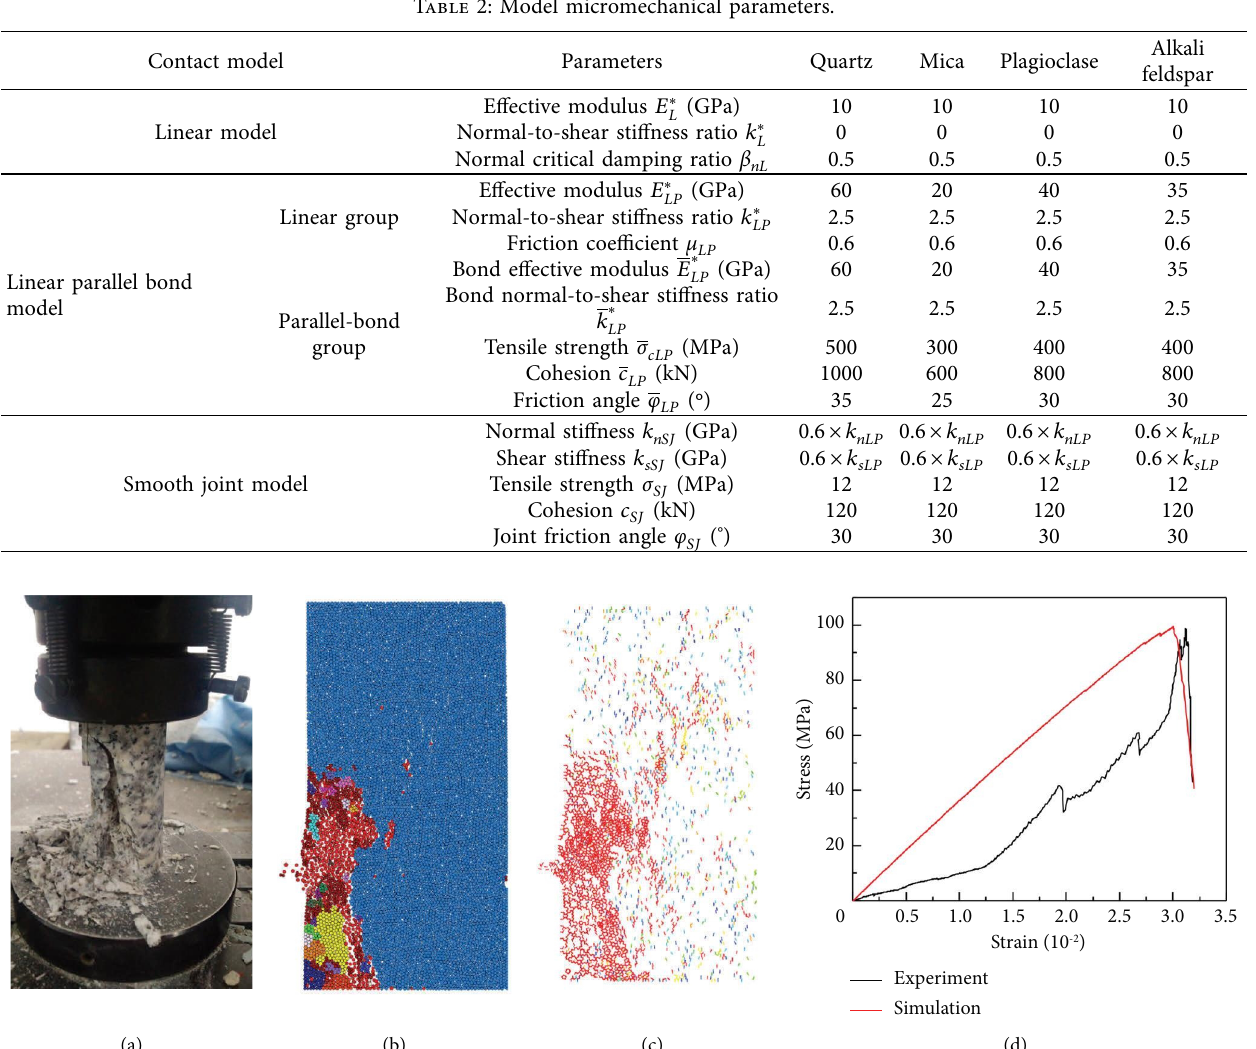
Table 2: Model micromechanical parameters.